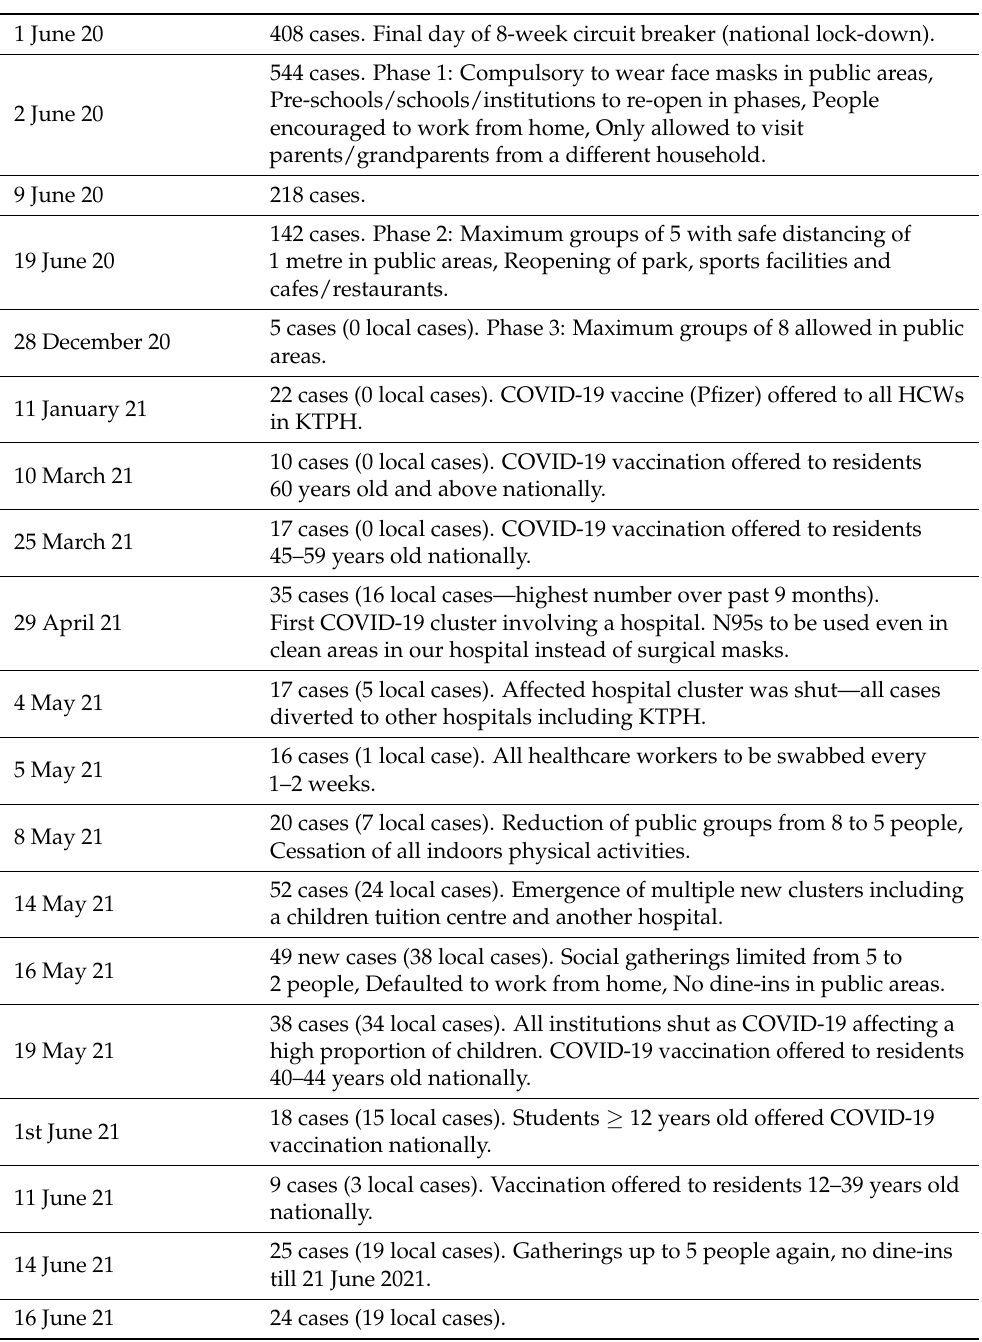
Table A1. Timeline of main changes in Singapore through the one-year period of the survey